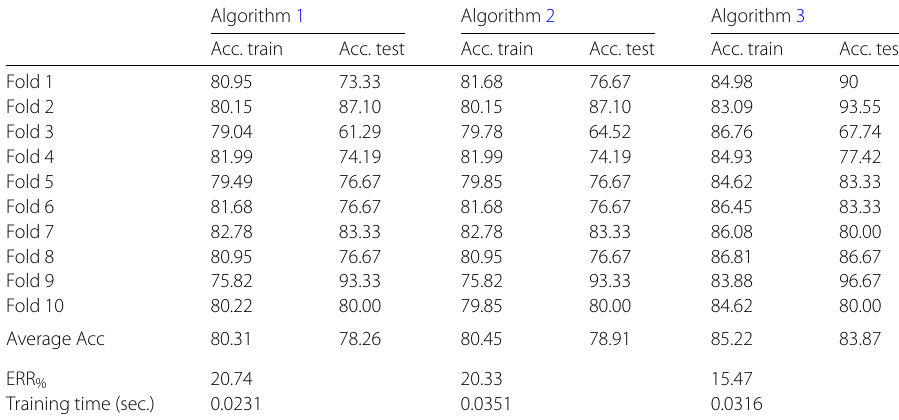
Table 10 Comparison of each algorithm at the 100th iteration with 10-fold CV. on heart disease